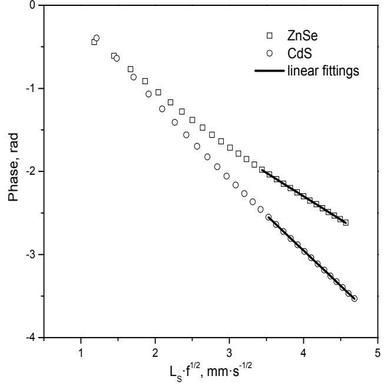
The BPPE phase characteristics of ZnSe (squares) and CdS (circles) crystals as the function of the square root of the modulation frequency multiplied by the sample thickness. The points are experimental data, and the lines are linear fits.